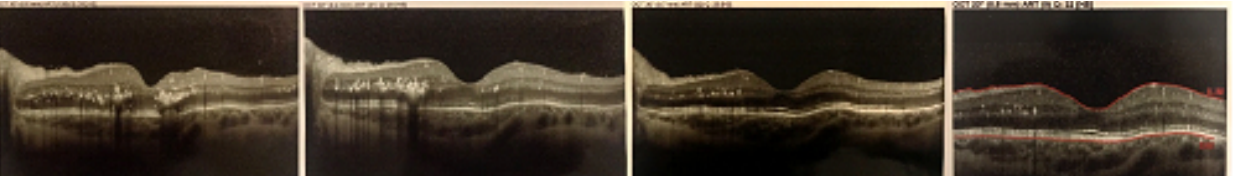
Figure 3. Macular optical coherence tomography at baseline, 3-month, 8-month, and 12-month visits (from left to